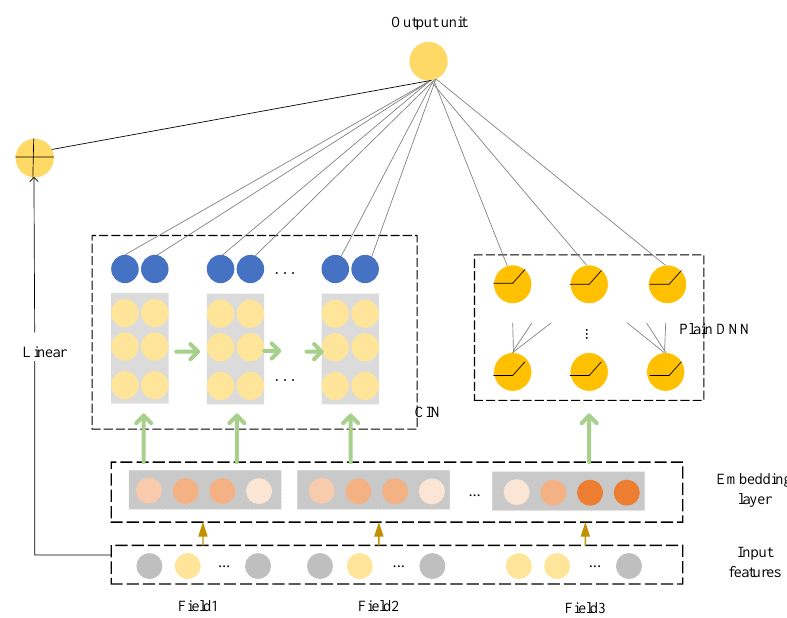
Figure 1. The structure of xDeepFM.